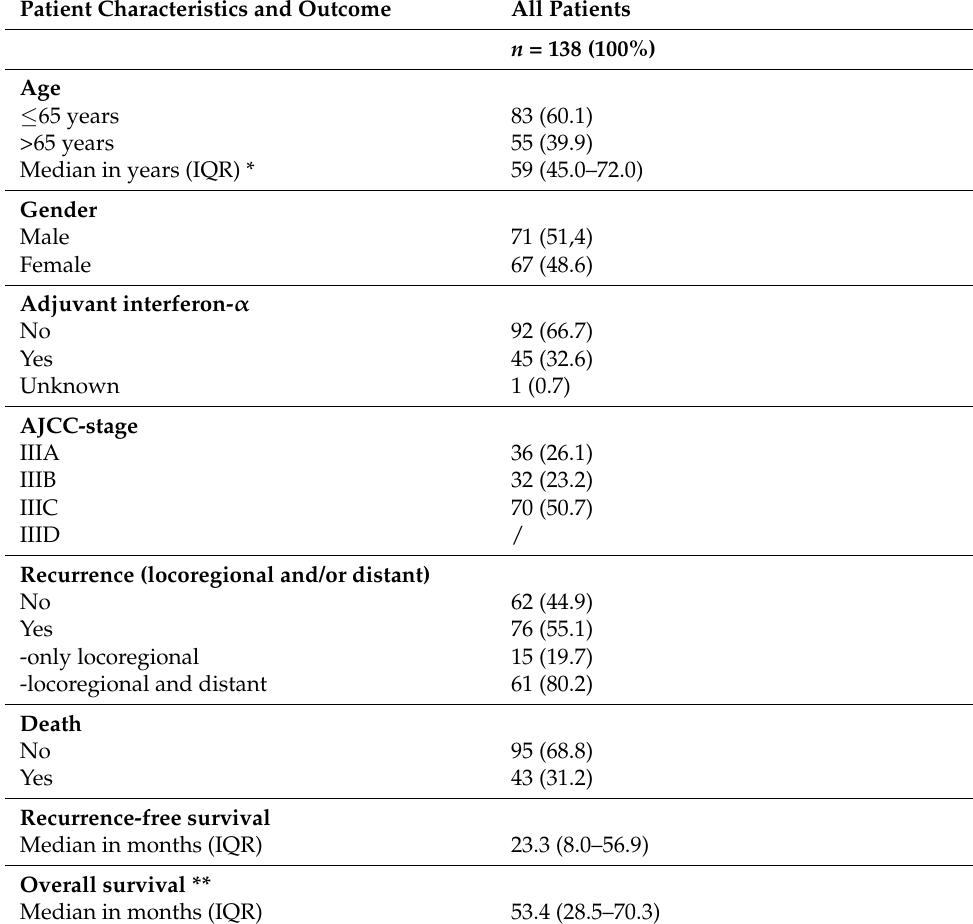
Table 1. Baseline characteristics and patient